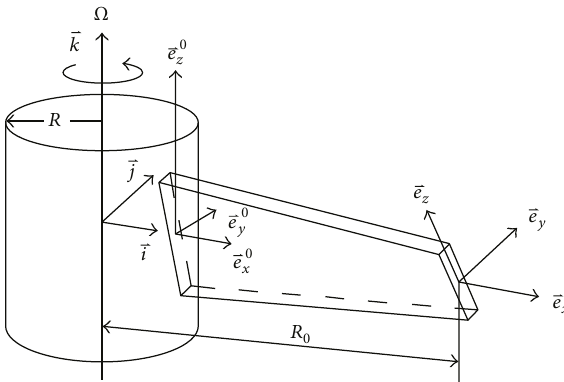
Figure 1: The model of the pretwist rotating cantilever rectangular plate.